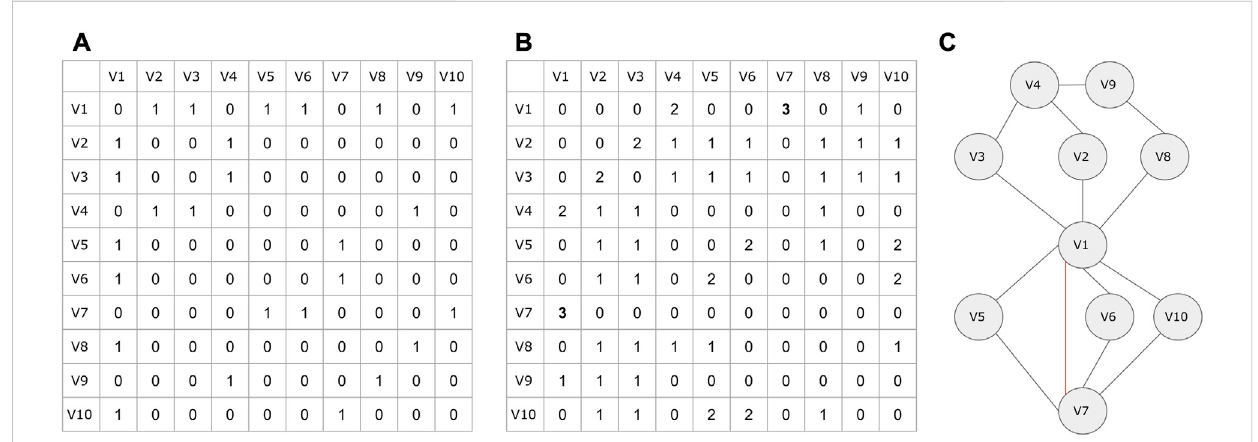
FIGURE 14 A triangle closing link prediction example. (A) The adjacency matrix of the undirected, unweighted example network. (B) The algebraic representation of the A 2 matrix. Each ( i,j ) value represents the number of common neighbors of the nodes i and j . (C) The example network plot. The red edge represents the new predicted link in time point t + 1